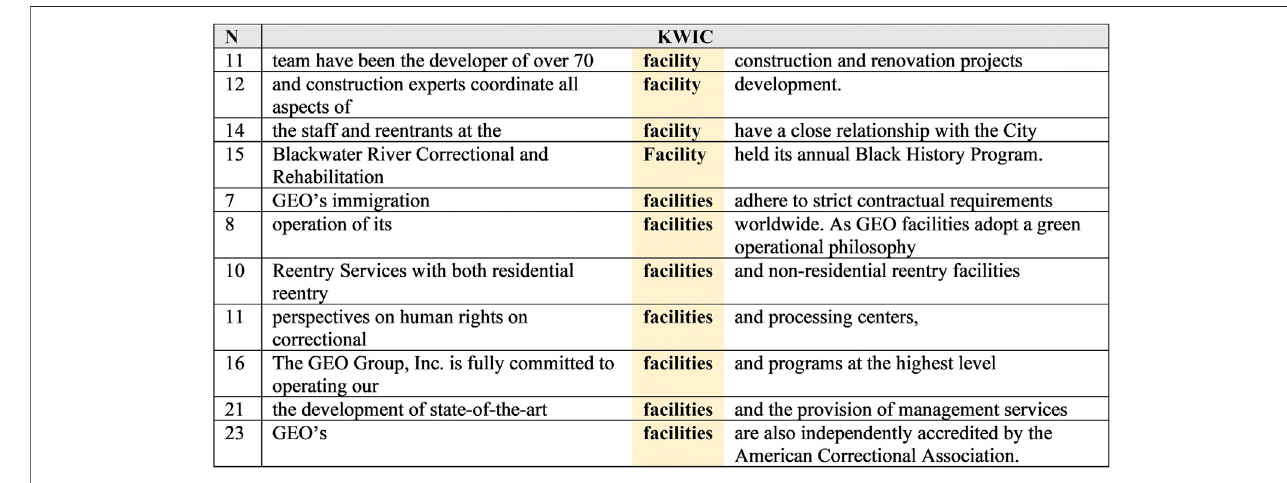
FIGURE 7 | The GEO corpus, “ facility ” and “ facilities ” concordance lines.